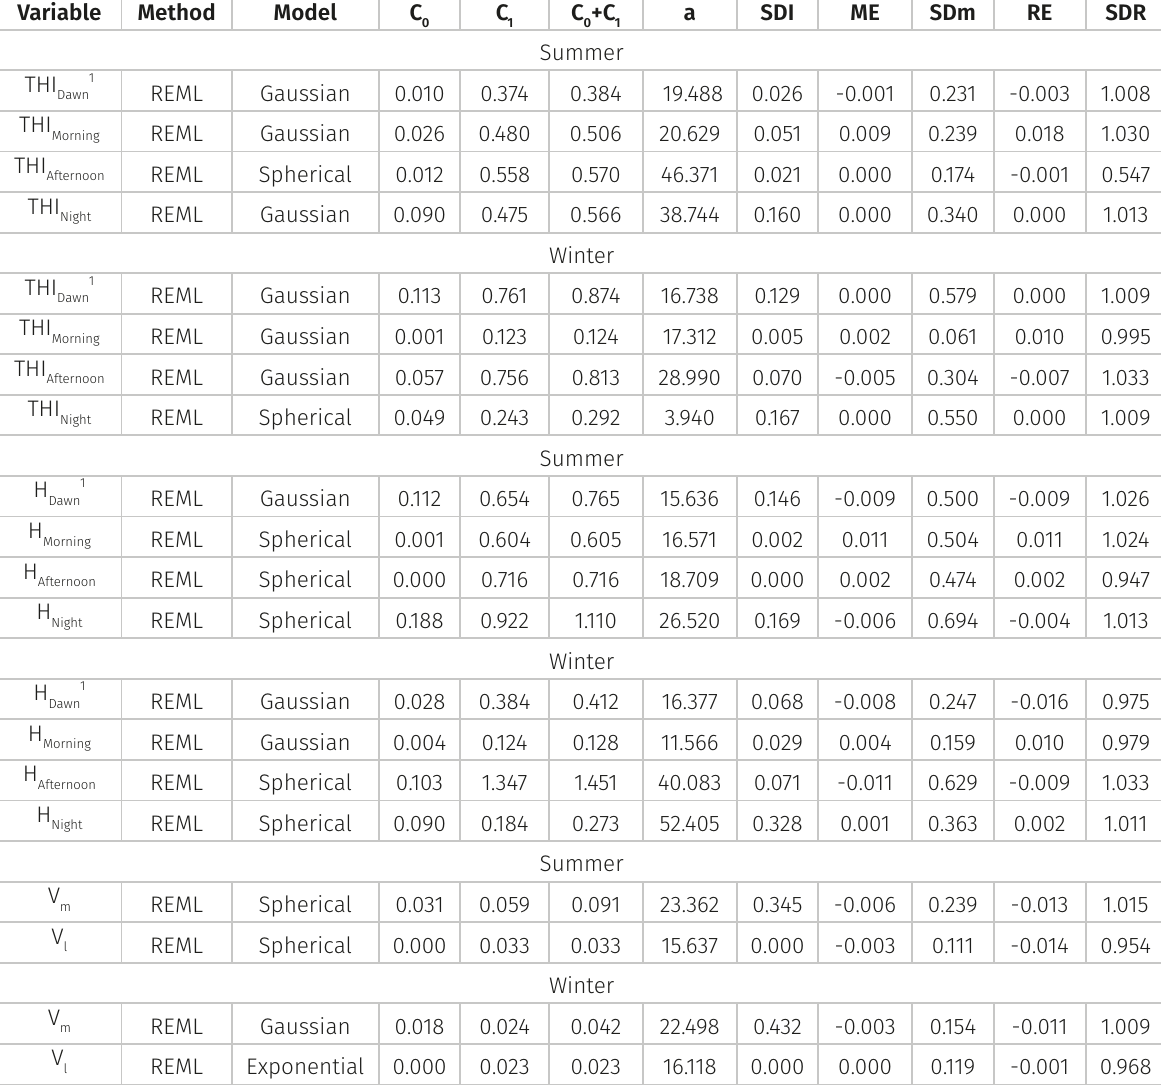
Table II. Method, model and estimated parameters of the experimental semivariogram for the mean values of